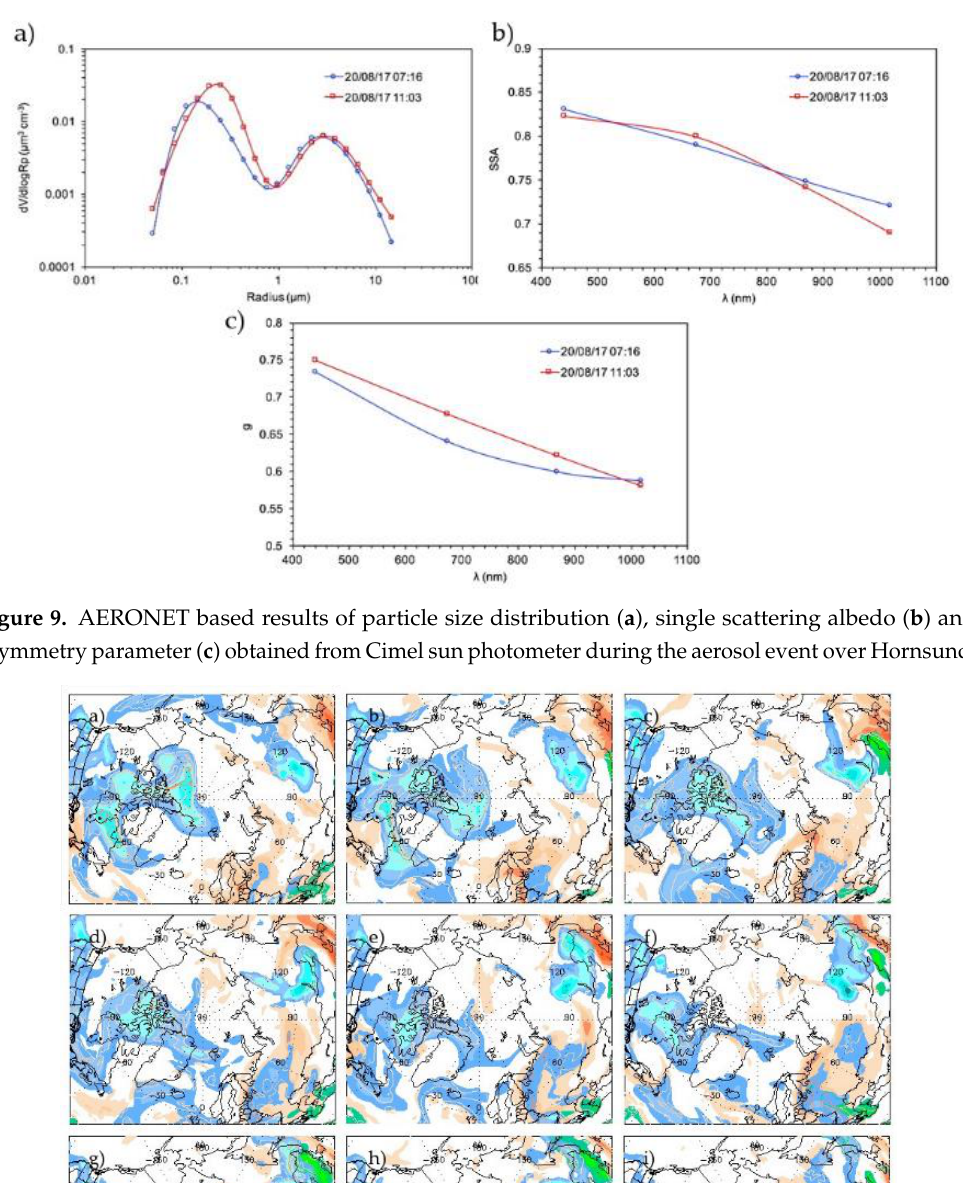
15 of 27 Figure 8. Ångström exponent (α) vs. aerosol optical depth at 500 nm (AOD 500 nm) retrievals form Hybrid Sky Scan inversions [94] at two AERONET sites in Spitsbergen. In addition, looking at the columnar size distribution of aerosol particles measured over Hornsund during the August event (Figure 9a), aerosol volume increased in the fine fraction along